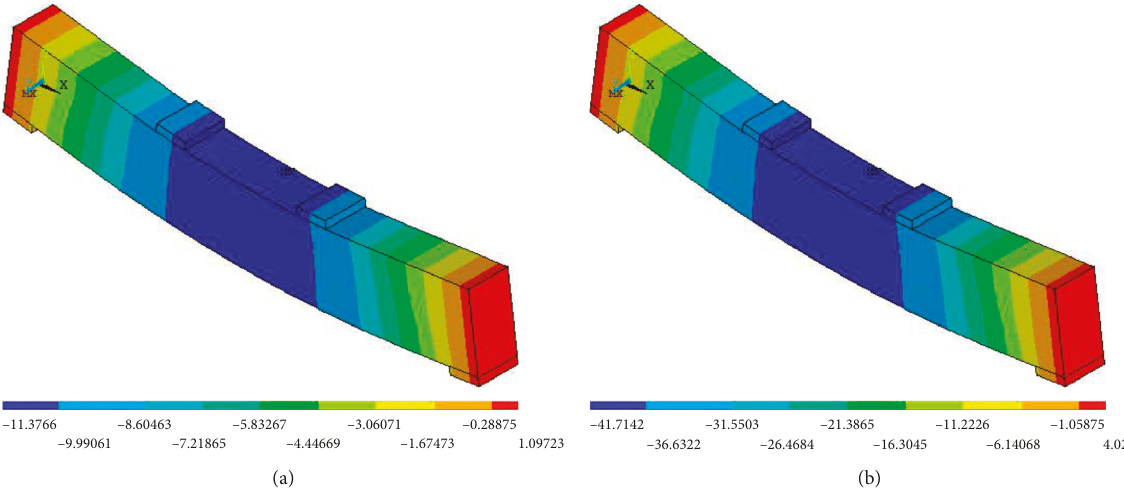
Figure 10: 3D views of deflections in the B2 model at (a) the yield load stage and (b) the maximum load stage.